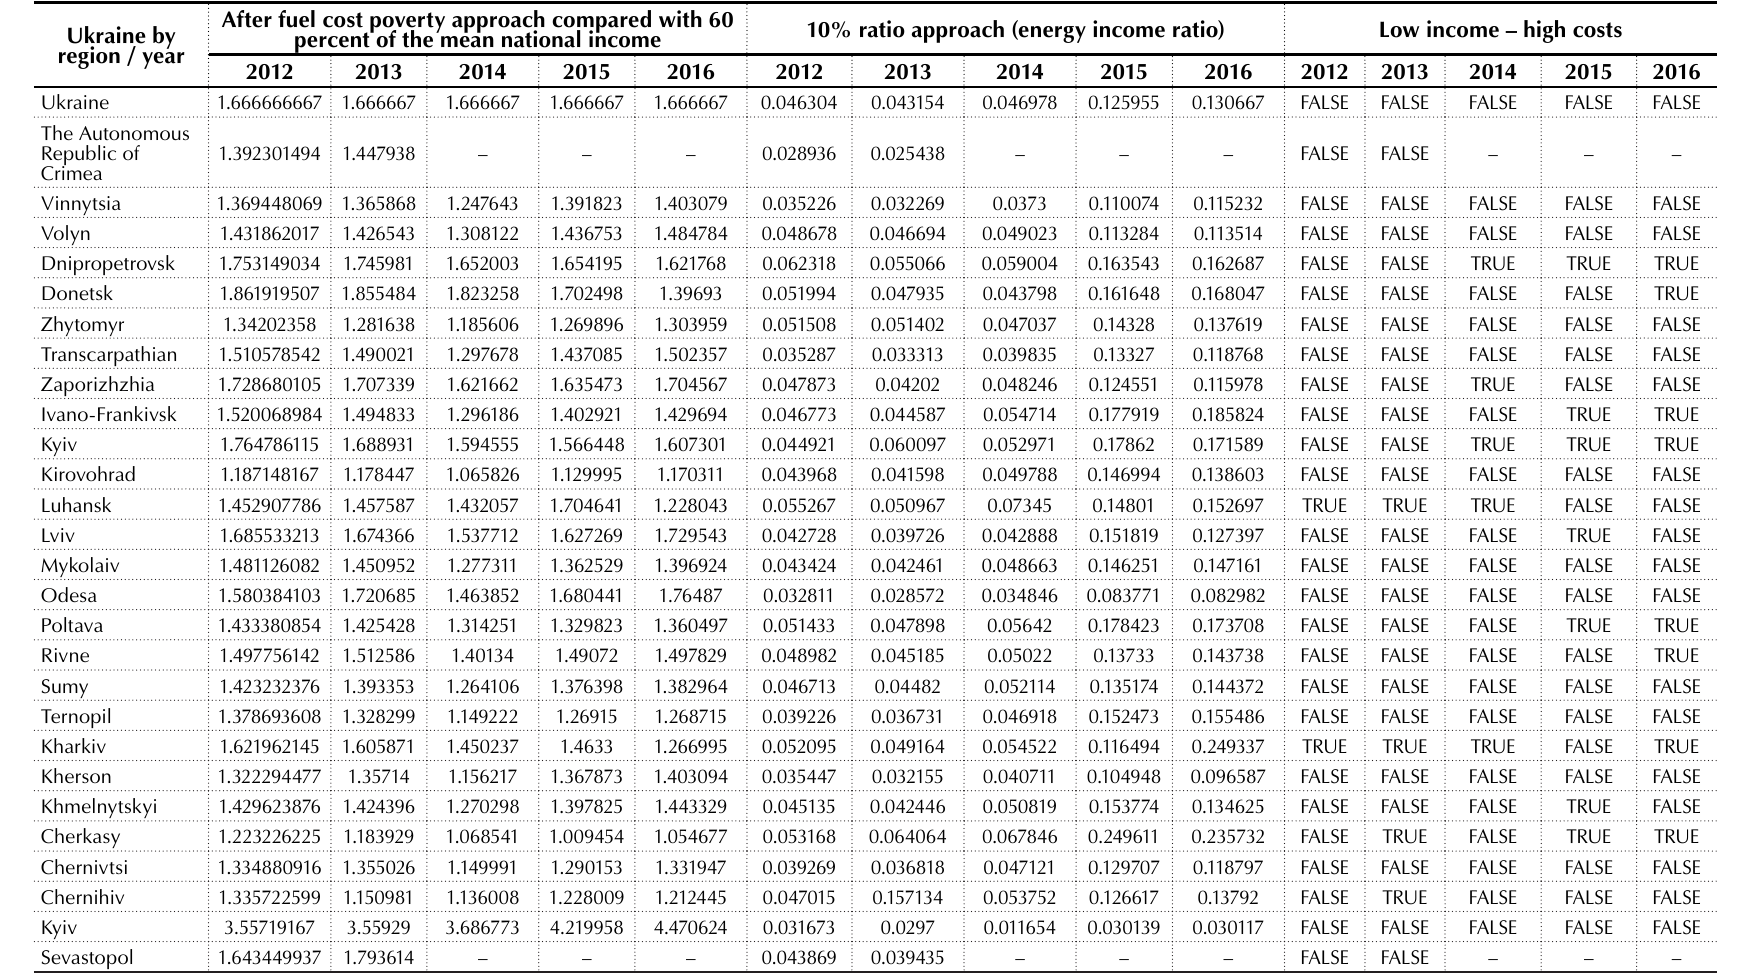
Table 1. Results of numerical simulation of the “fuel